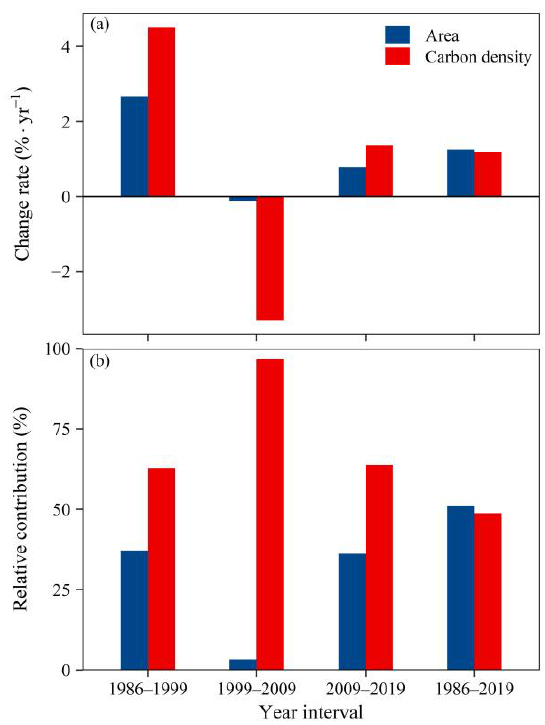
Figure 7. Annual mean change rates of forest area and vegetation carbon density ( a ) and their relative contributions to change in forest vegetation carbon storage ( b ) in different stages.